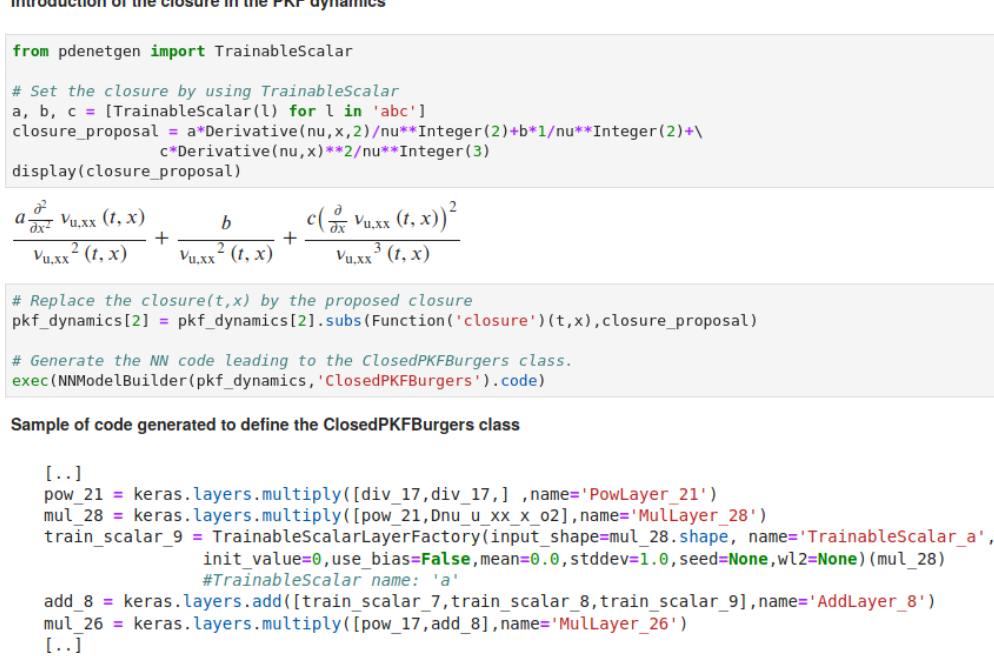
Figure 5. Implementation of the closure by defining each unknown quantity as an instance of the class TrainableScalar and the resulting generated NN code. This is part of the code available in the Jupyter notebook given as an example in the package